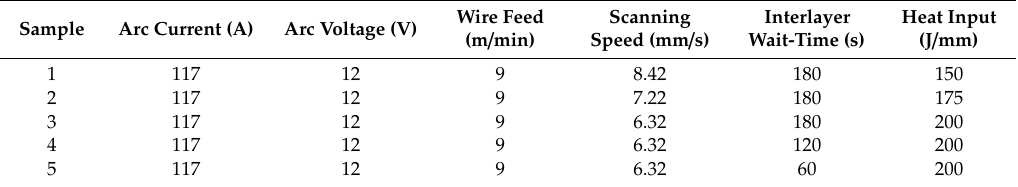
Figure 2. Pictures of five wire + arc additive manufacturing (WAAM) samples with different processing parameters.